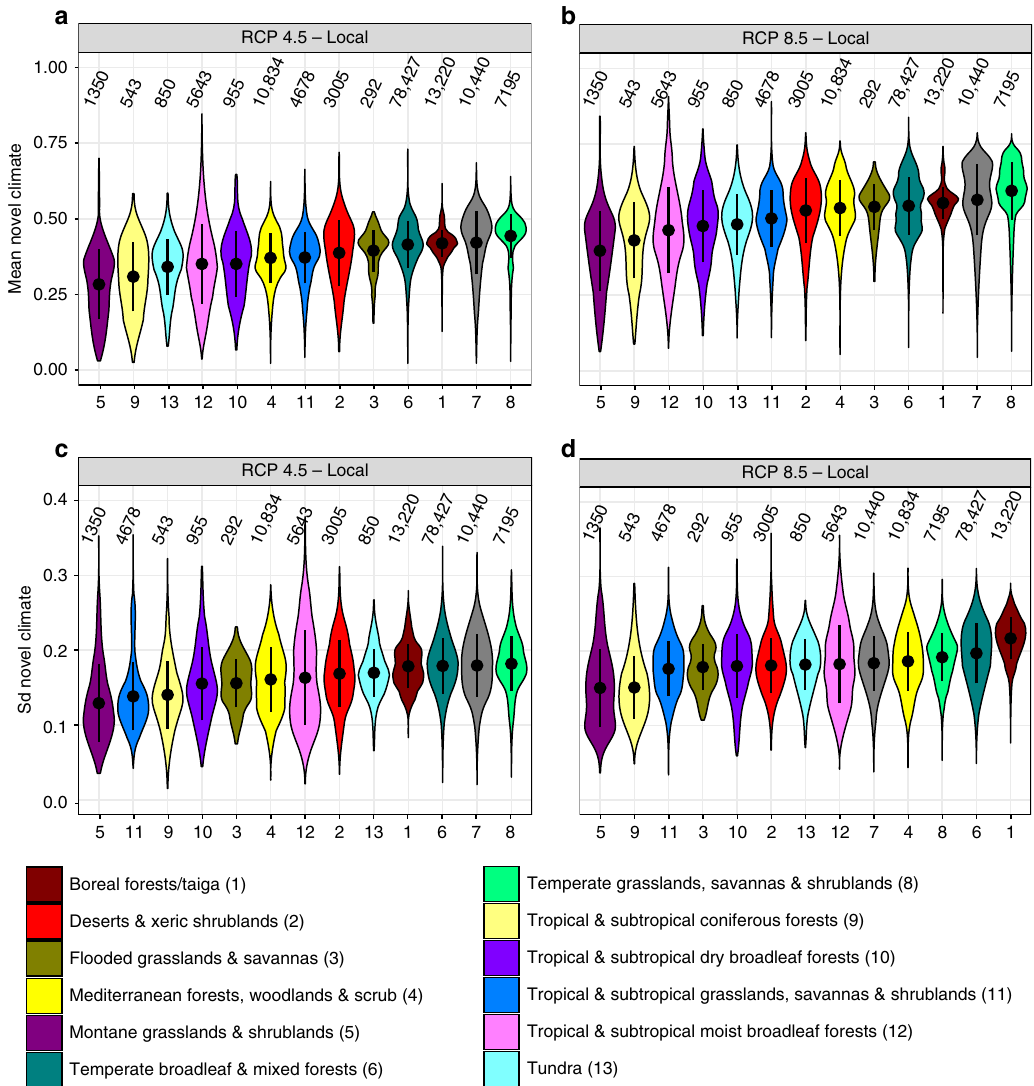
Fig. 3 Local-scale novel climate index of terrestrial protected areas worldwide, summarized by biomes. The mean of the local-scale novel climate index under a RCP 4.5 and b RCP 8.5. The standard deviation (sd) of the local-scale novel climate index under c RCP 4.5 and d RCP 8.5. Sd represents the variation of the local-scale novel climate index resulting from ten GCMs. Violins per biome are ordered by increasing mean. Black dots and attached lines within violins represent the mean ± standard deviation. Black numbers above violins indicate the number of PAs within the respective biome. Data on climate change metrics and other characteristics per PA are given as Supplementary Data 1. Source data are provided as a Source Data fi (Fig. 2c, d; RCP 4.5: r = 0.56, p < 0.001 using a modi fi ed t -test accounting for spatial autocorrelation; 19 RCP 8.5: r = 0.43, p <